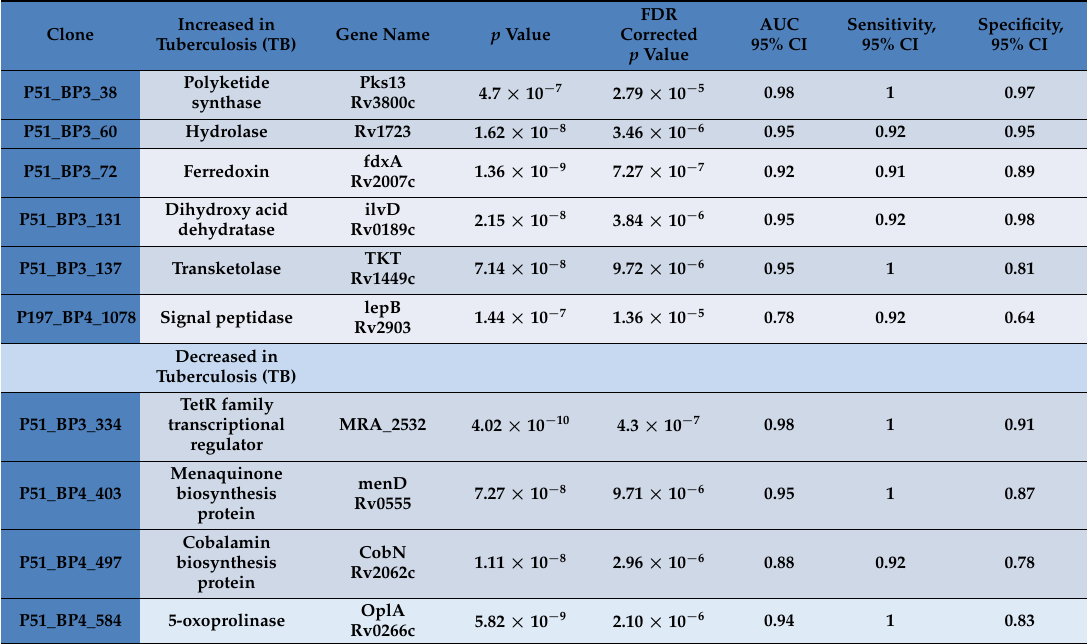
Table 2. 10 Top Significant TB